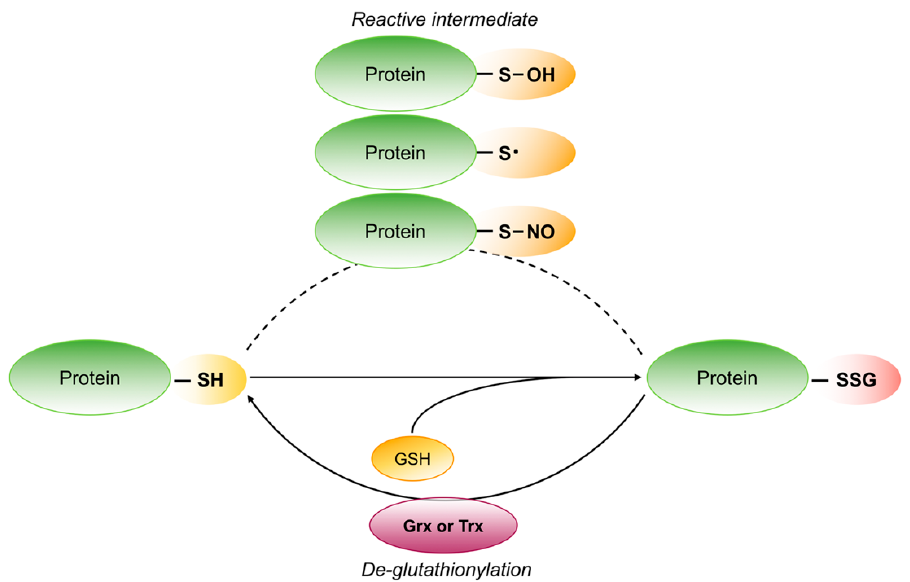
Figure 7. Schematic representation of reversible protein S-glutathionylation. The thiol groups on Figure7. SchematicrepresentationofreversibleproteinS-glutathionylation. Thethiolgroupsonreactive reactive cysteine are S-glutathionylated after the formation of different reactive intermediate. S- cysteine are S-glutathionylated after the formation of di ff erent reactive intermediate. S-glutathionylation glutathionylation can be reversed by glutaredoxin (Grx) or thioredoxin (Trx). can be reversed by glutaredoxin (Grx) or thioredoxin